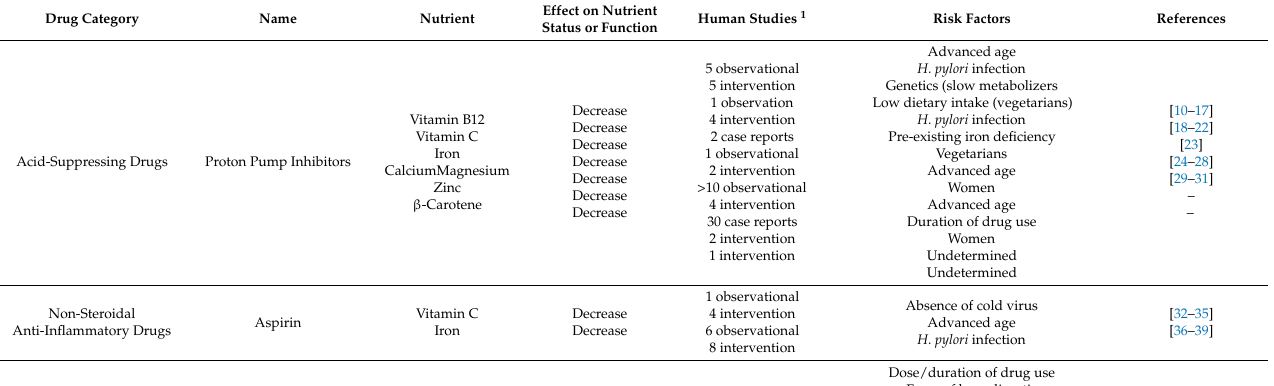
Table 1. Summary of potential drug–nutrient interactions and known risk